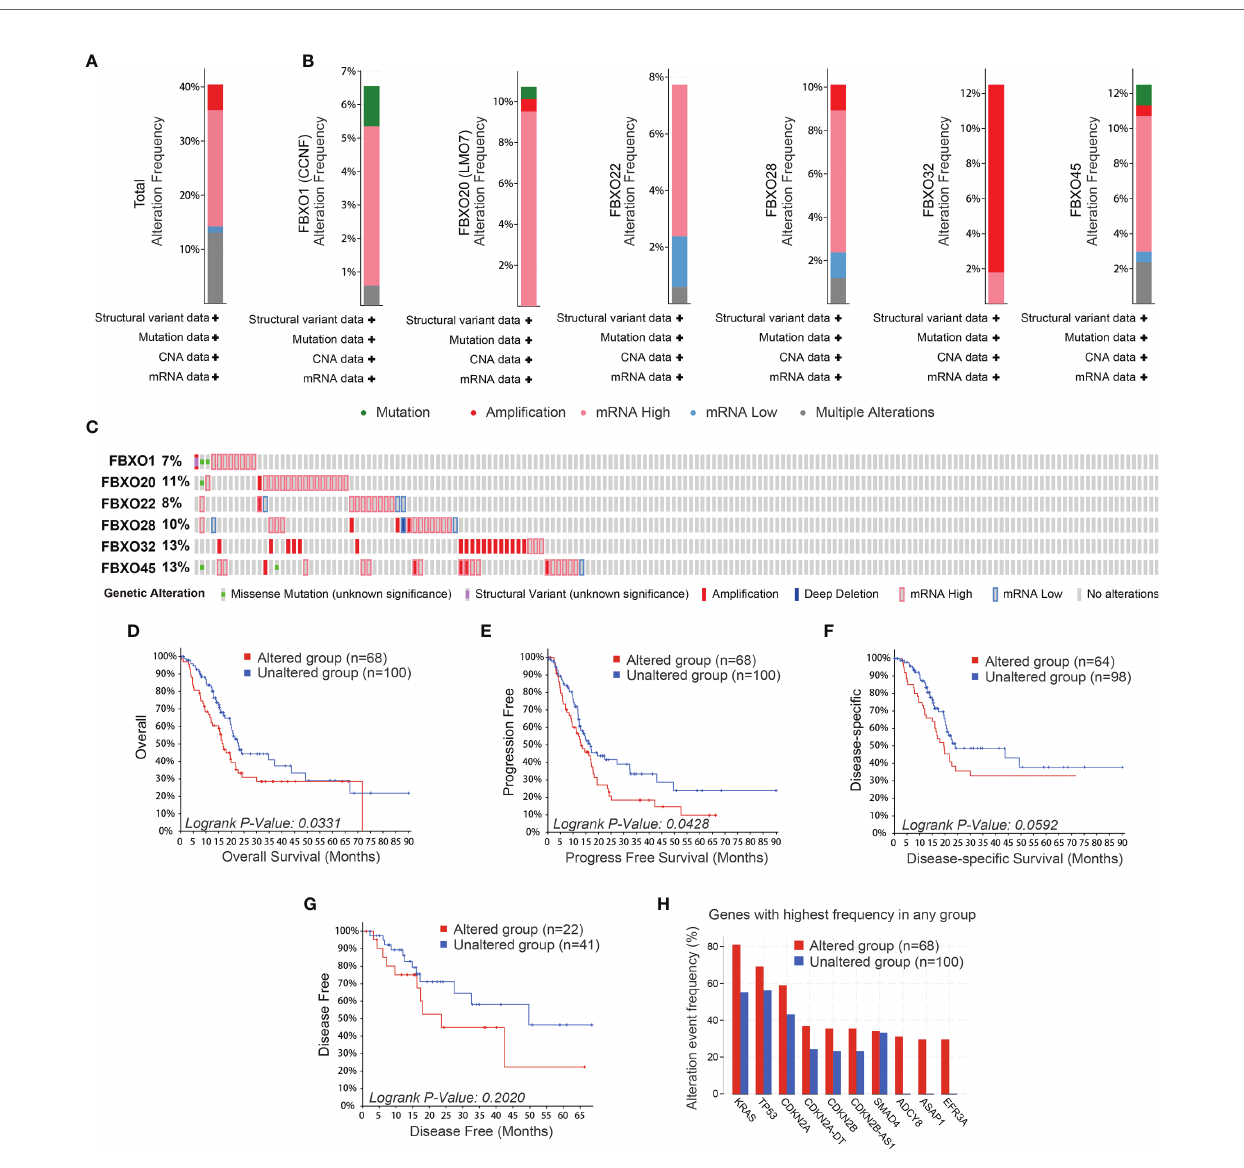
FIGURE 7 | The genetic alteration and mutation of six-FBXOs in PDAC using cBioPortal database. (A) Total alteration frequency of the six-FBXOs in PDAC. (B, C) Individual alteration frequency of six-FBXOs in PDAC. (D – G) The prognostic analysis of the genetic alteration of the six-FBXOs in PDAC, including overall ( p = 0.0331), progression-free ( p = 0.0428), disease-speci fi c ( p = 0.0592), and disease-free survival ( p = 0.2020). (H) Alteration event frequency of common mutant genes between altered group ( n = 68) and unaltered group ( n =